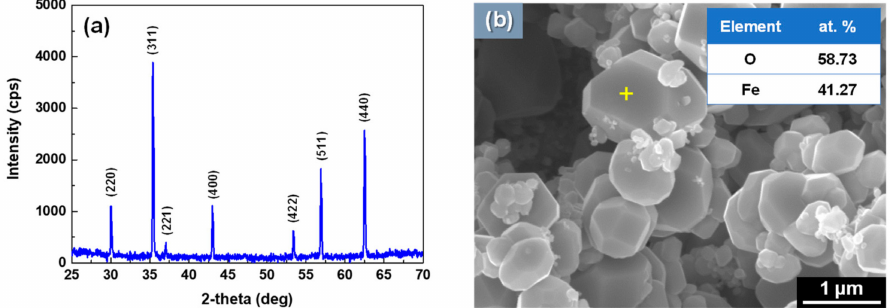
Figure 10. ( a ) X-ray di ff ractometer (XRD) pattern of simulated deposit and ( b ) a representative chemical composition of particle deposited in the test by SEM-energy dispersive X-ray spectrometer (EDS)